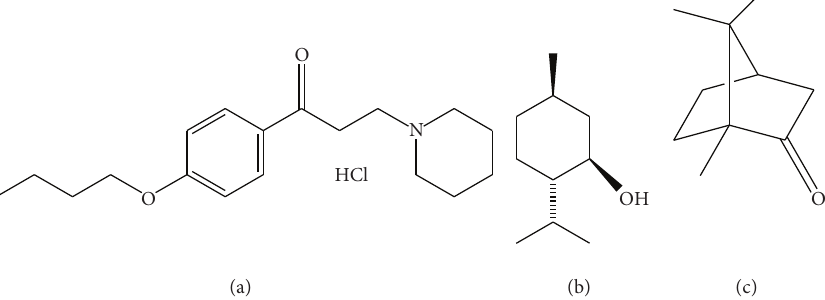
F 1: Typical chemical structures of (a) dyclonine hydrochloride, (b) menthol, and (c)